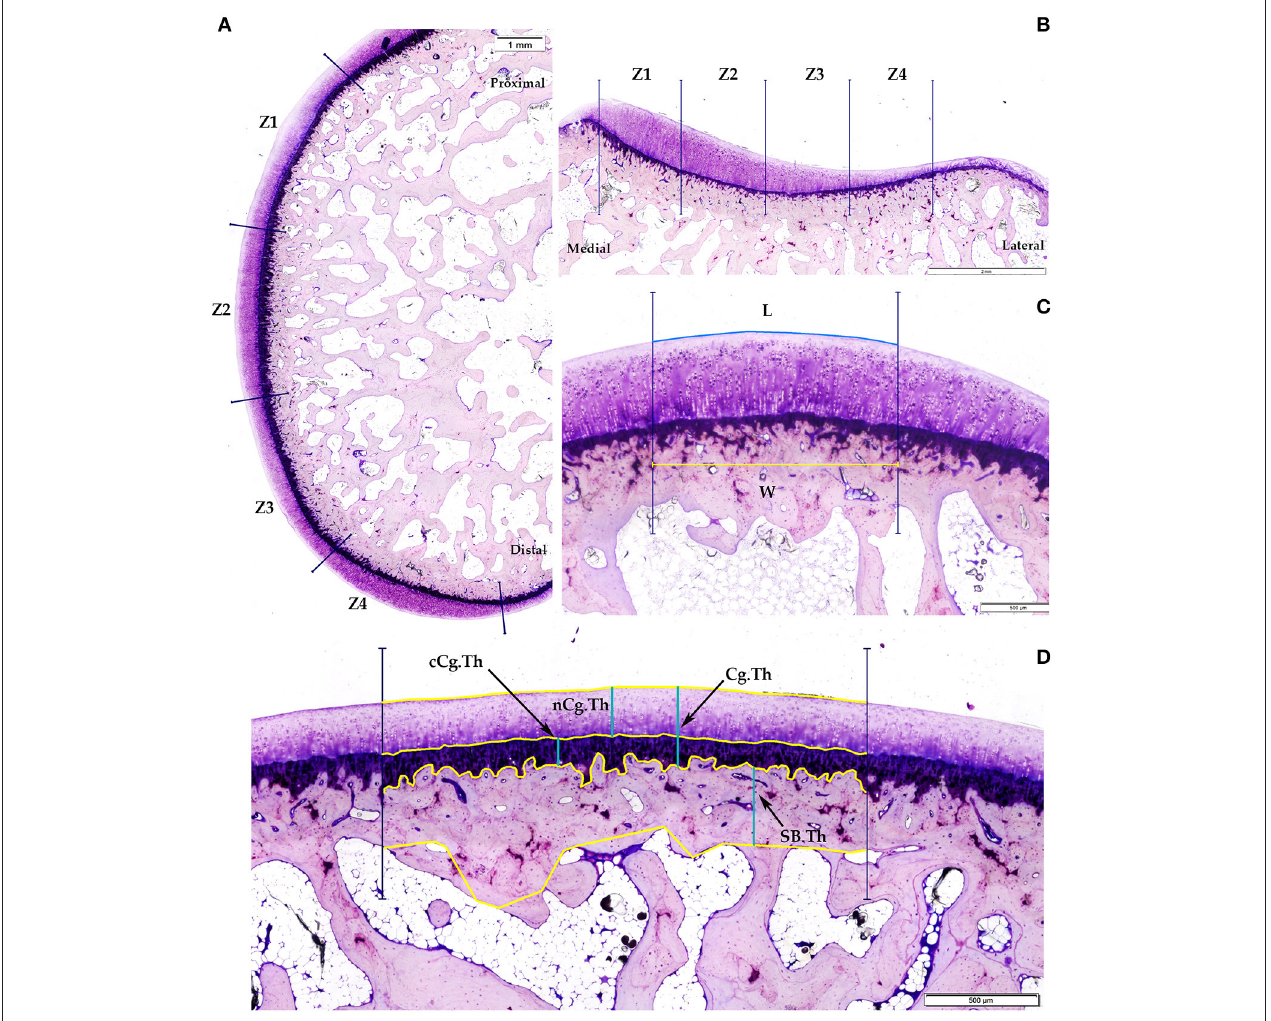
FIGURE 2 | Representative images of histomorphometric analysis. (A) Femoral condyle ROI; (B) Tibial plateau ROI; (C) Fibrillation index (FI) calculated as the difference between the length of the cartilage surface (L) and a straight parallel with the same width line (W); (D) Cartilage and subchondral bone thickness: cCg.Th, non-calcified cartilage thicknes; cCg.Th, calcified-cartilage thickness; Cg.Th, total cartilage thickness; SB.Th, subchondral bone cortical